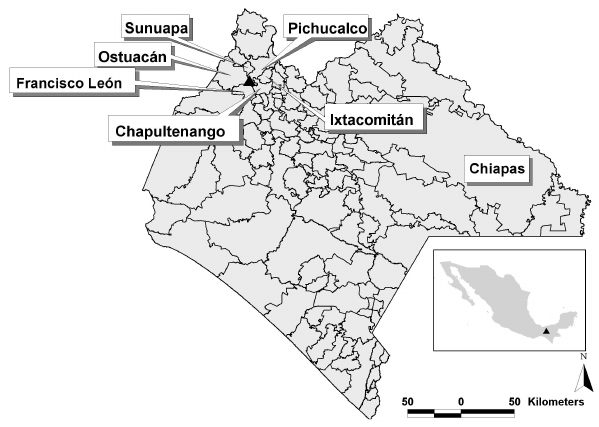
Fig. 11. Municipalities located near the El Chich´on volcano.